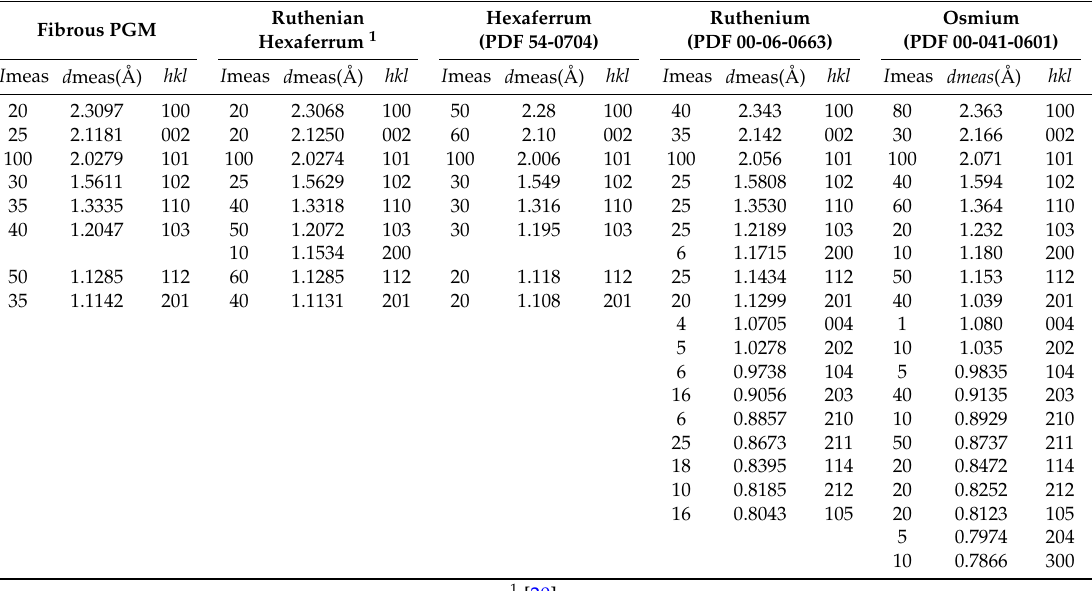
Table 1. Powder X-ray data for the fibrous platinum-group mineral (PGM) shown in Figure 3A and comparison with chemically related phases.